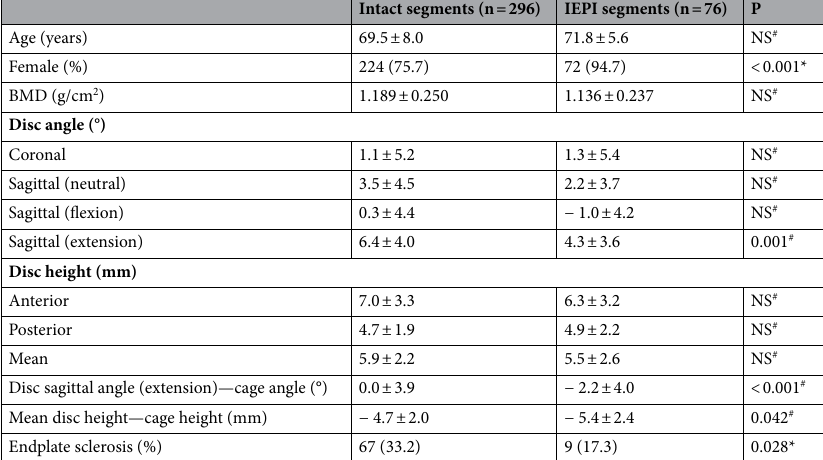
Table 4. Comparison of demographic and radiographic data between intact segments and intraoperative endplate injury (IEPI) segments. BMD bone mineral density, NS not significant. # Student’s t-test was performed. *Chi-squared test was